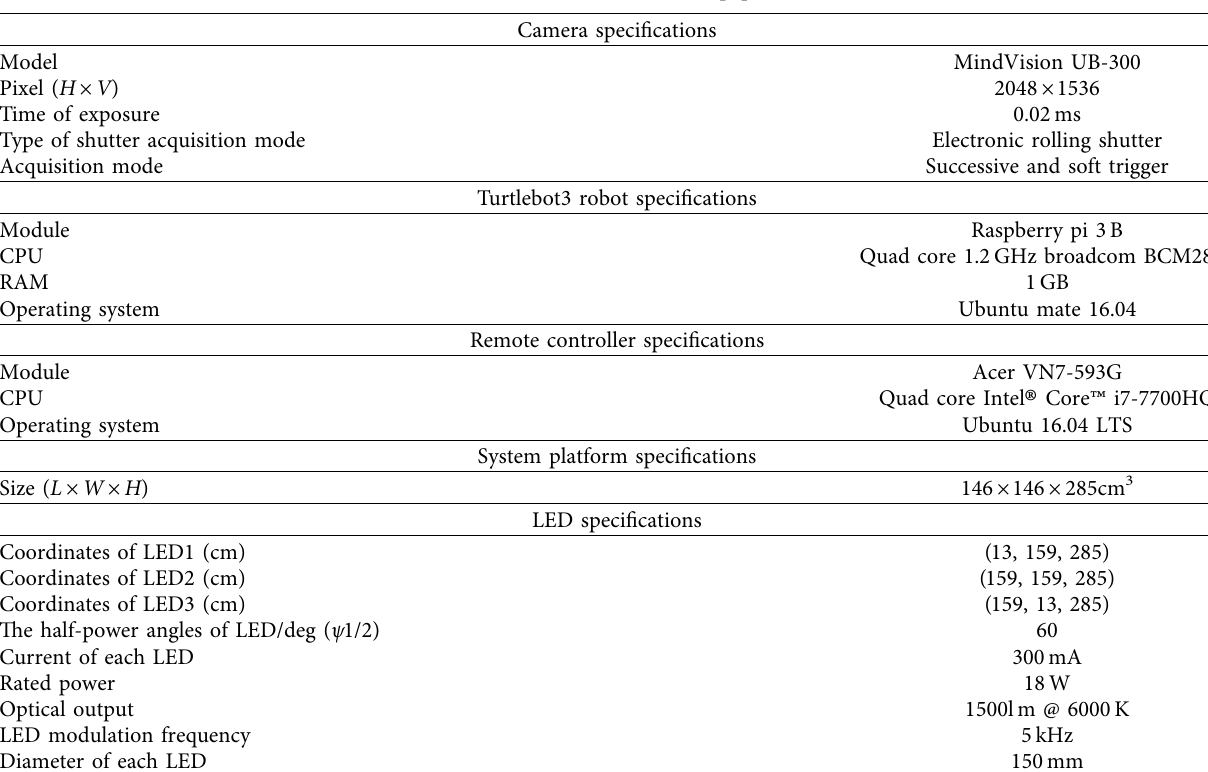
Figure 8: The procedure of triple-light positioning. Table 1: Parameters in this